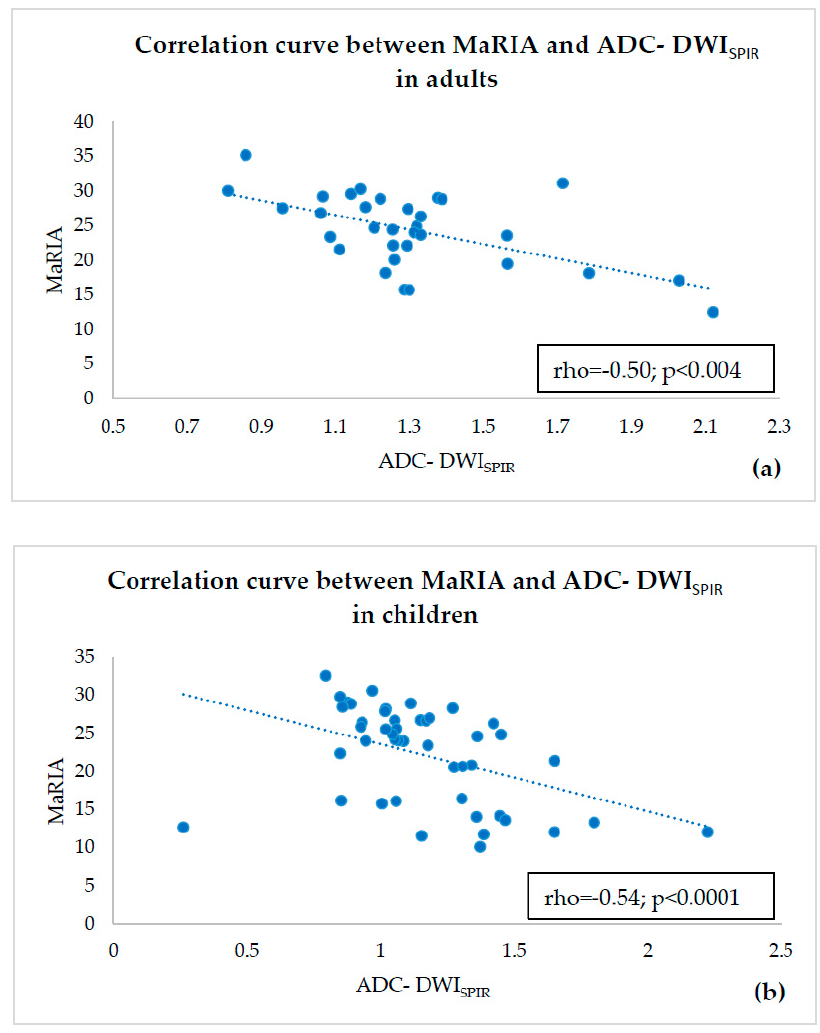
Figure 6. Correlation curve between ADC-DWI SPIR and MaRIA in adults ( a ) and children ( b ) showing moderate negative correlation.